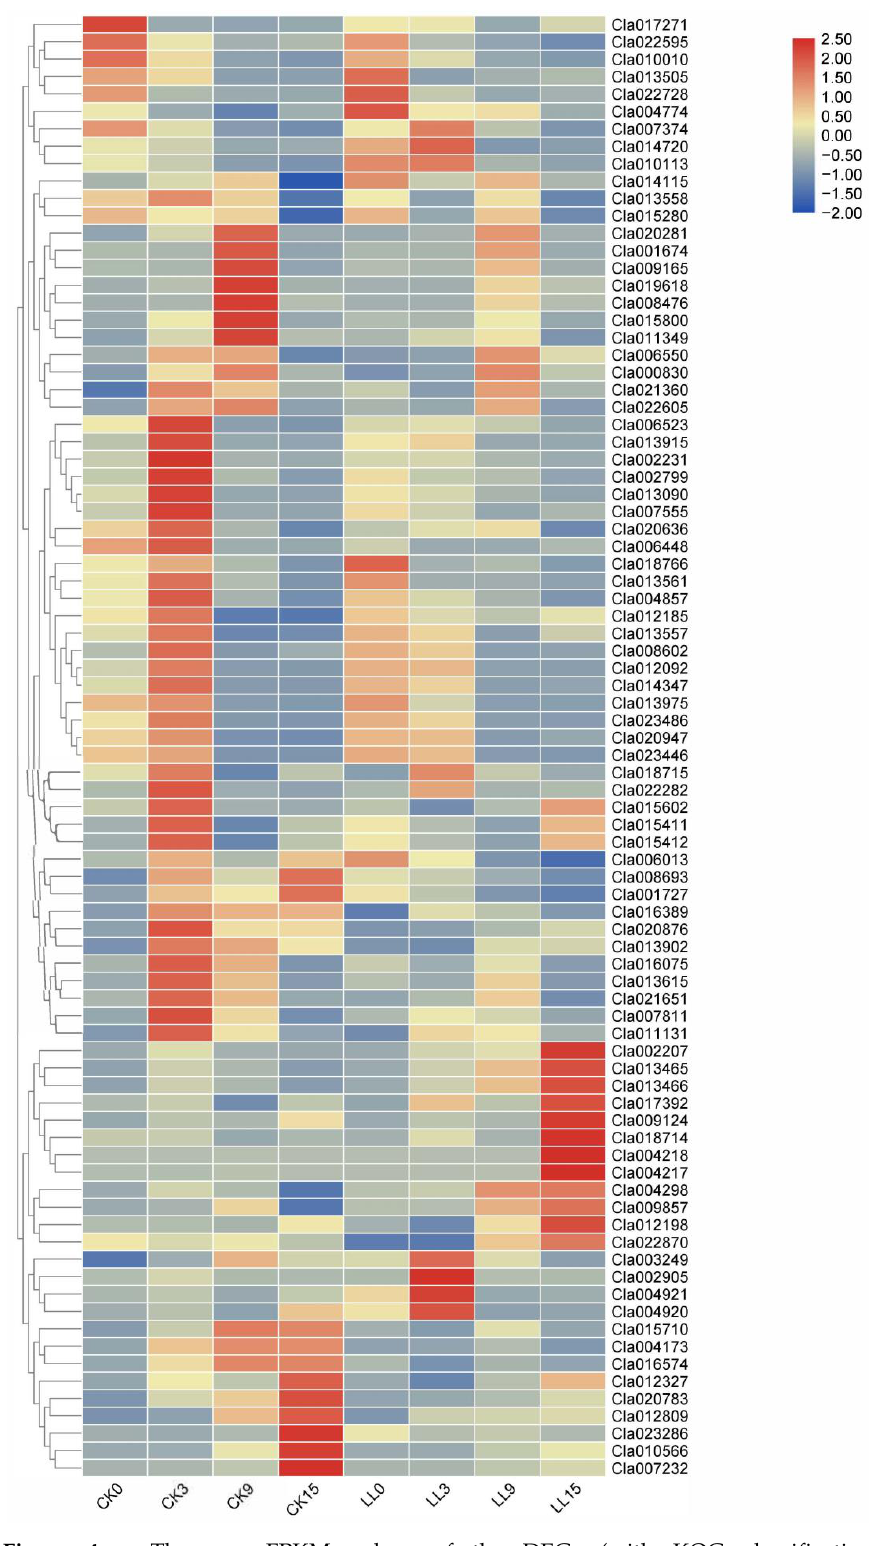
Figure 4. The raw FPKM values of the DEGs (with KOG classification was cell wall/membrane/envelop biogenesis and cell cycle control, cell division, chromosome partition- ing) were first normalized by logarithmic method and a heat map was constructed to show the different expression profiles using the Heml software (version 1.0, http://hemi.biocuckoo.org/. accessed on 9 July 2020). X -axis, samples; Y -axis, differentially expressed gene